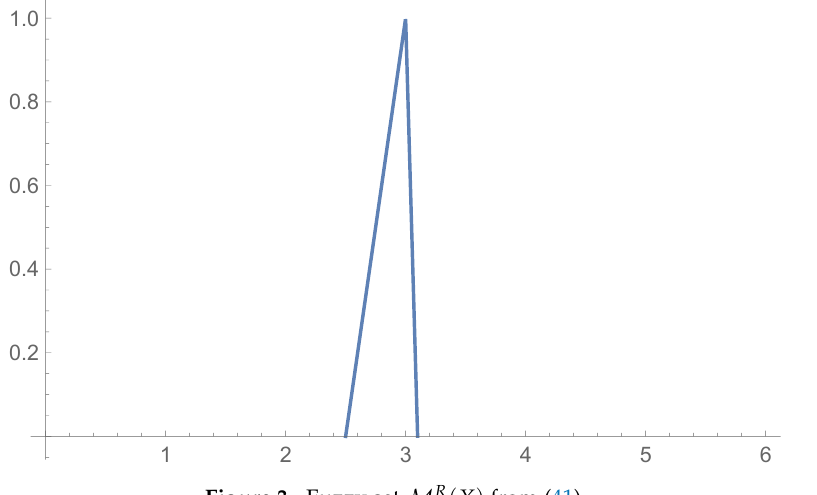
Figure 3. Fuzzy set M R p ( X ) from